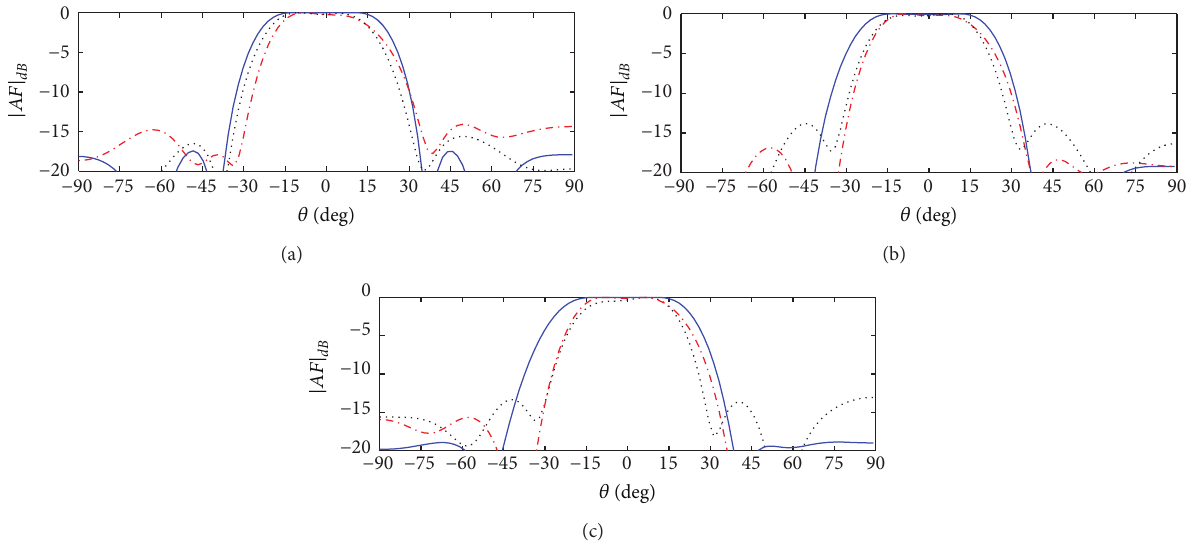
Figure 4: Optimized flat-top patterns from the concentric ring array: (a) for 𝜑 = 0 degree plan,e (b) for 𝜑 = 5 degree plane, (c) for 𝜑 = 10 degree plane.